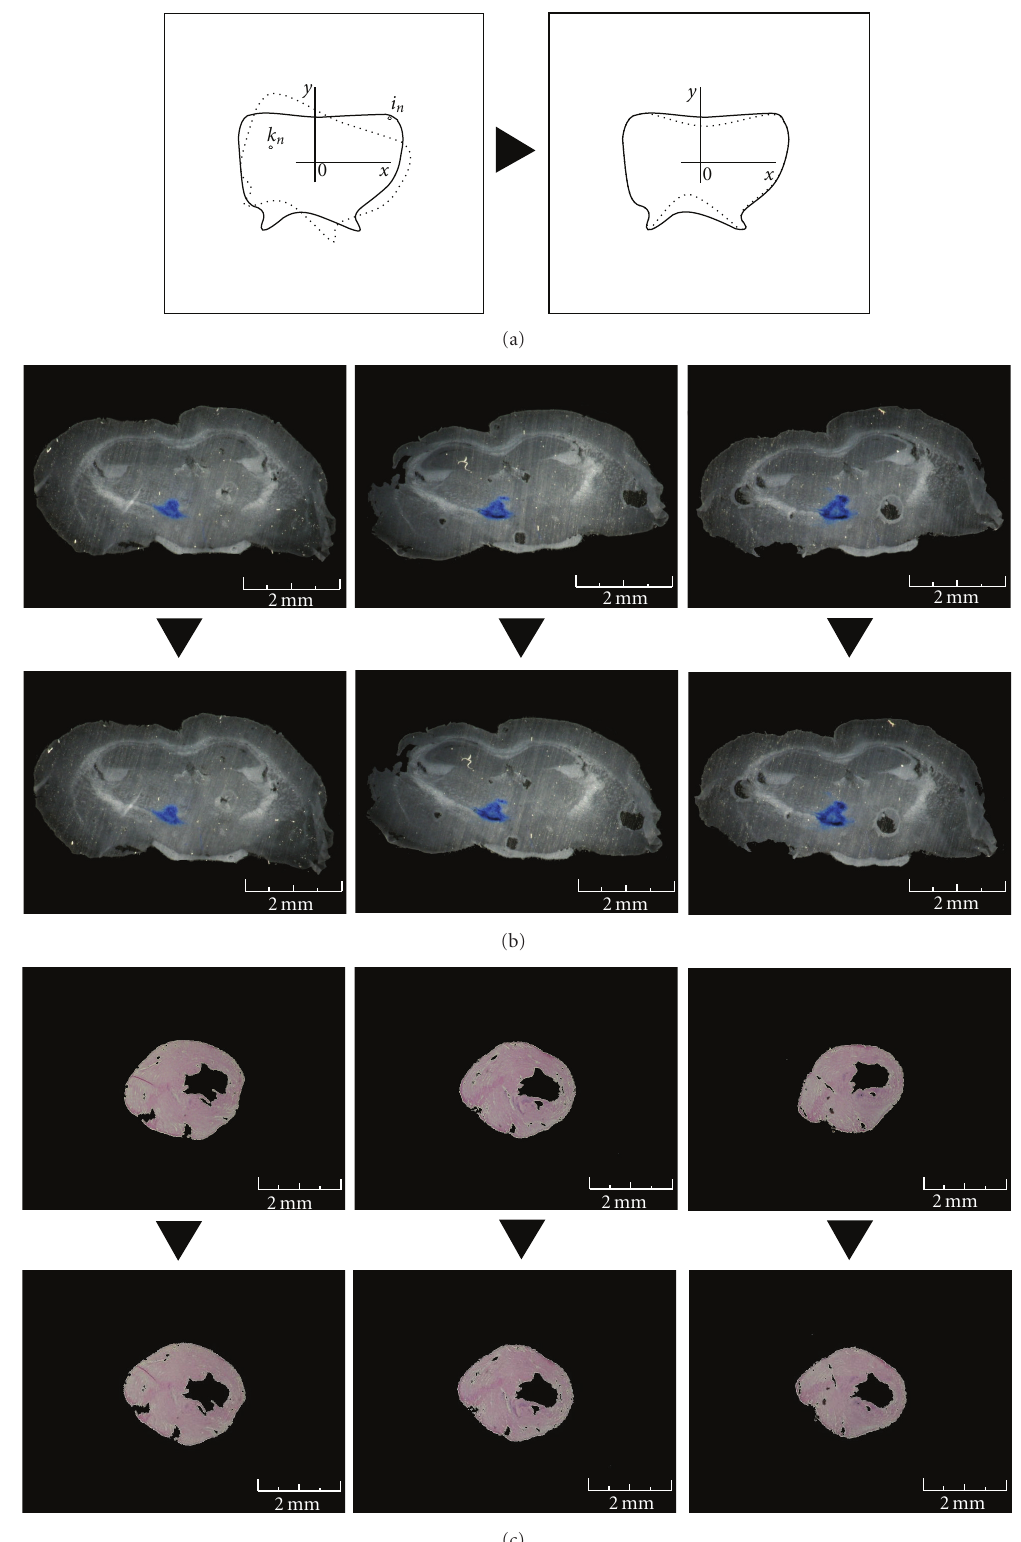
Figure 3: Woven image orientation. (a) Outline of the image orienting routine (see routine 2). The images of the woven area were oriented regarding the adjacent slides by the routine that rotates the woven area of the bitmap 360 ◦ , then it chooses the angle where the di ff erences between the adjacent images are the smallest, and hence, the images are the most similar. i is the intensity of the pixel number of the first image and k is the intensity of the pixel n of the previous image. The image chosen is the one with the smallest value of d . (b) Example of the image-orienting procedure: In the panels we can see two of the images obtained from the brain serial sections that are rotated with respect to the adjacent image. (c) The same procedure has been used for the heart section